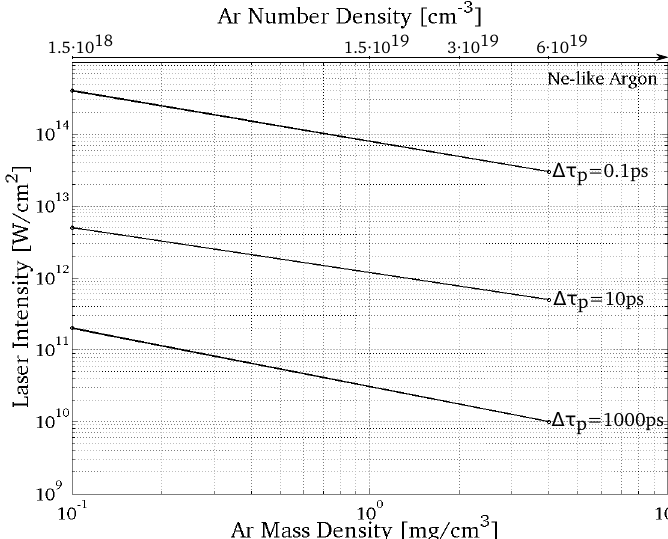
Figure 9. Optimum laser intensity for having Ne-like Ar +8 as a function of Ar 0 density at different pulse durations. The top axis is the number density (cm − 3